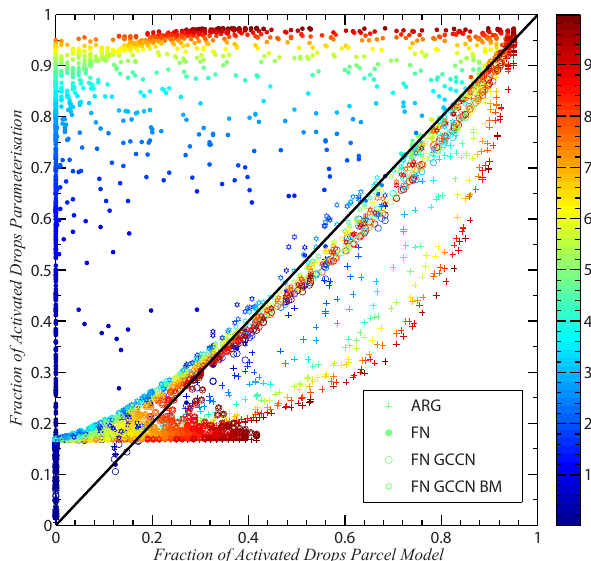
Figure 2. Results from 1500 runs with 1 lognormal mode of am- monium sulfate aerosol with randomly sampled variable values as detailed in Table 2 and initial conditions described in Table 1. Sym- bols are coloured by median aerosol diameter (nm).